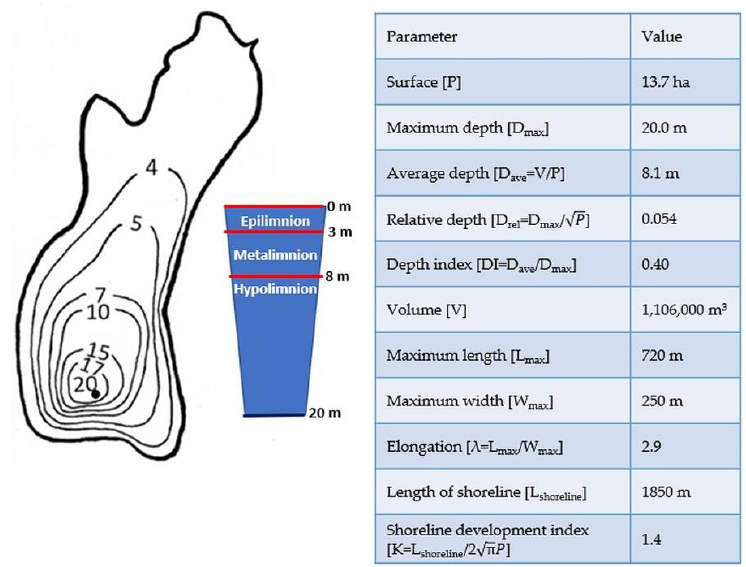
Figure 2. Morphometric data of Lake Klasztorne Małe (Inland Fisheries Institute in Olsztyn).